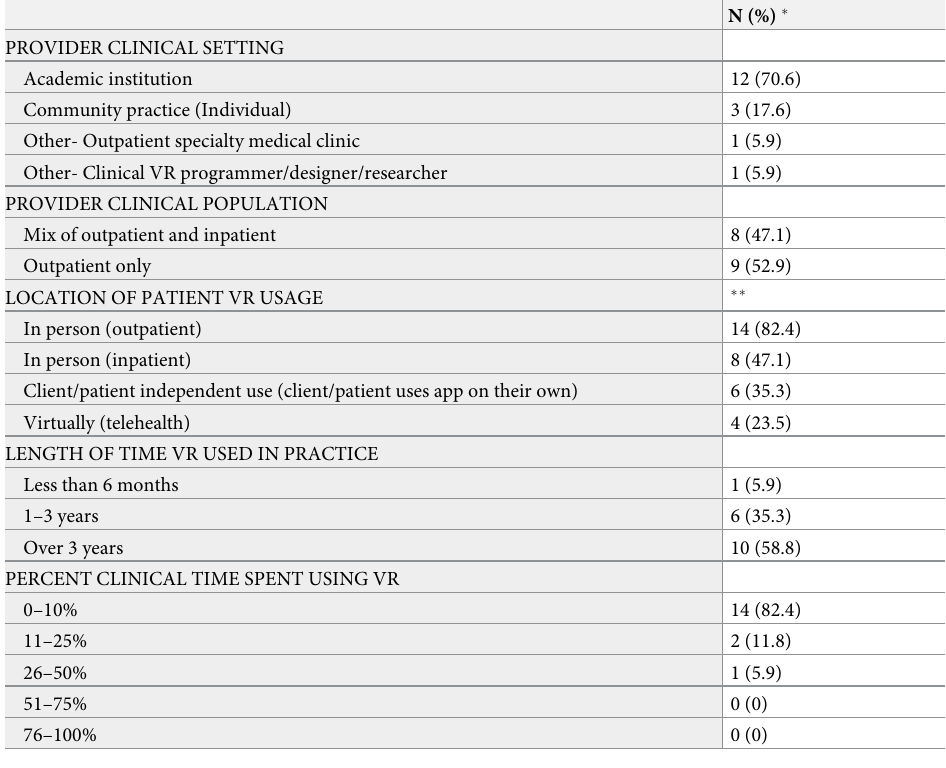
Table 1. VR in practice: Location, population, and time using